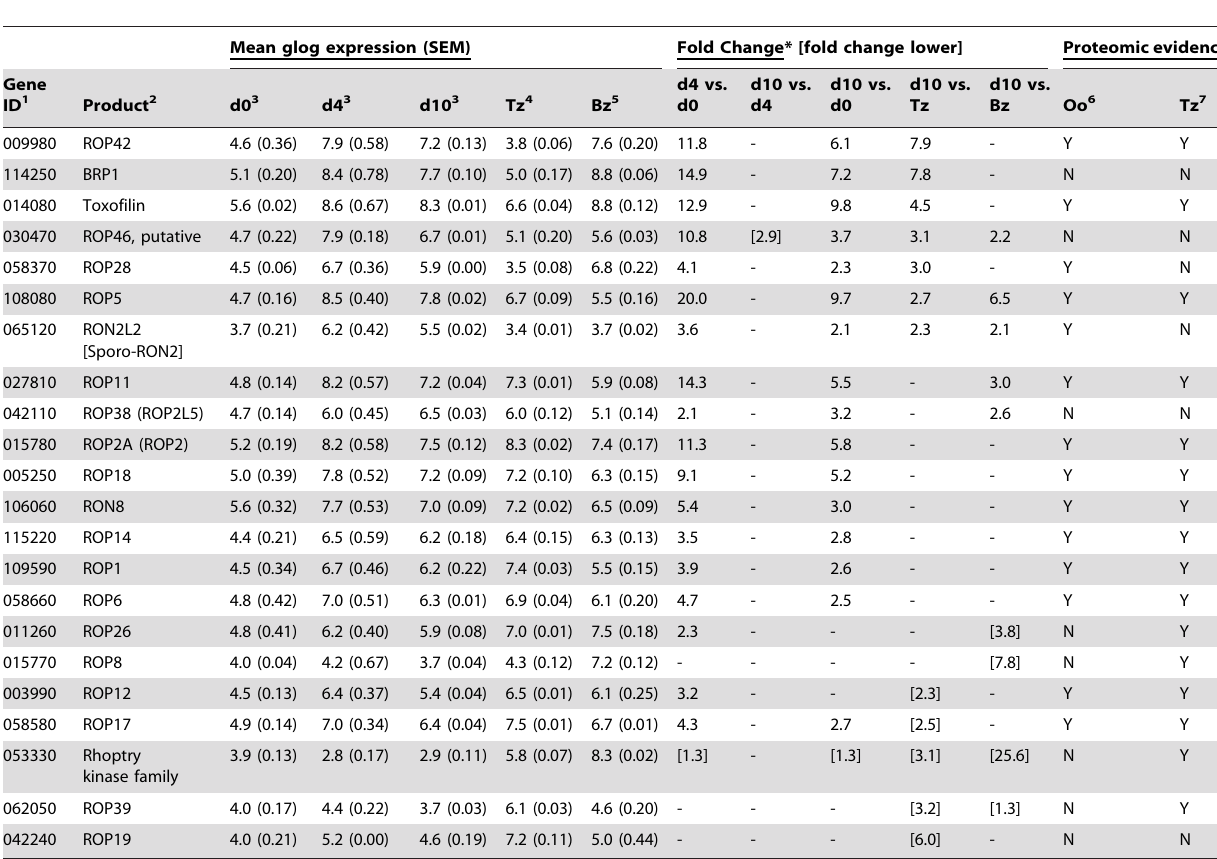
Table 6. Functionally interesting genes of Toxoplasma gondii oocysts at different stages of maturation with a comparison to bradyzoite and tachyzoite expression levels - rhoptry